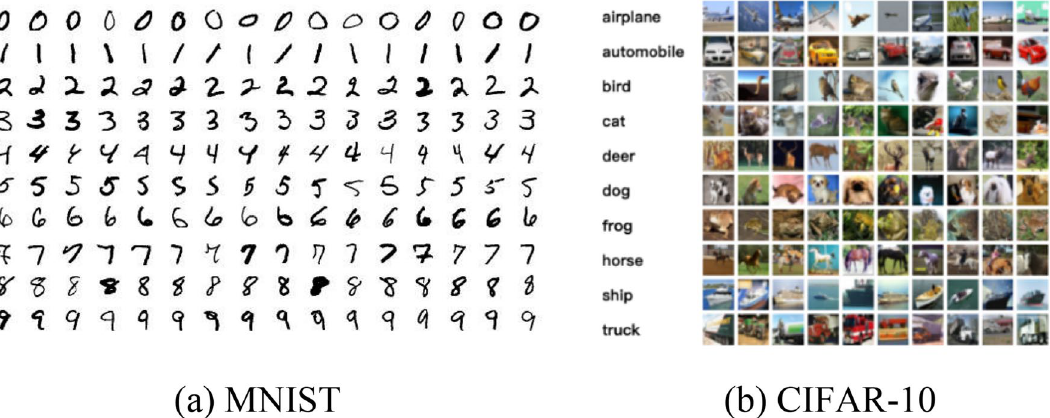
Figure 5. Datasets. ( a ) MNIST is composed of many handwritten from different people. Training set contains of 250 digits and test set consists of the same proportion of digits data. ( b ) CIFAR-10 is widely used in lots of image classification research. There are 50,000 32 × 32 images in the training set and 10,000 32 × 32 images in the test